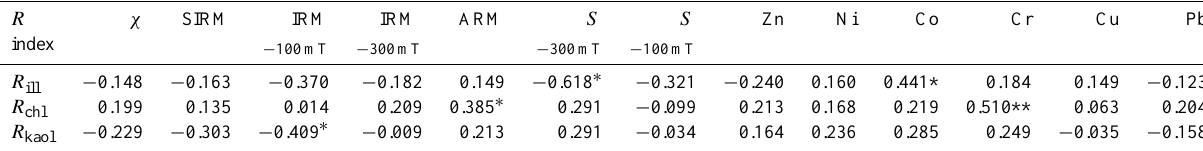
Table 7. Spearman’s correlations between R index and magnetic parameters and content of toxic